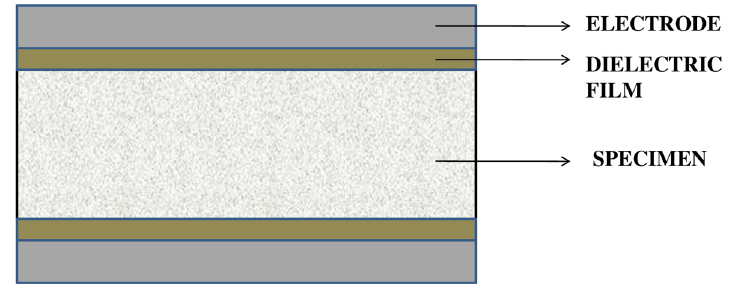
Figure 7. The specimen setup for capacitance measurement.